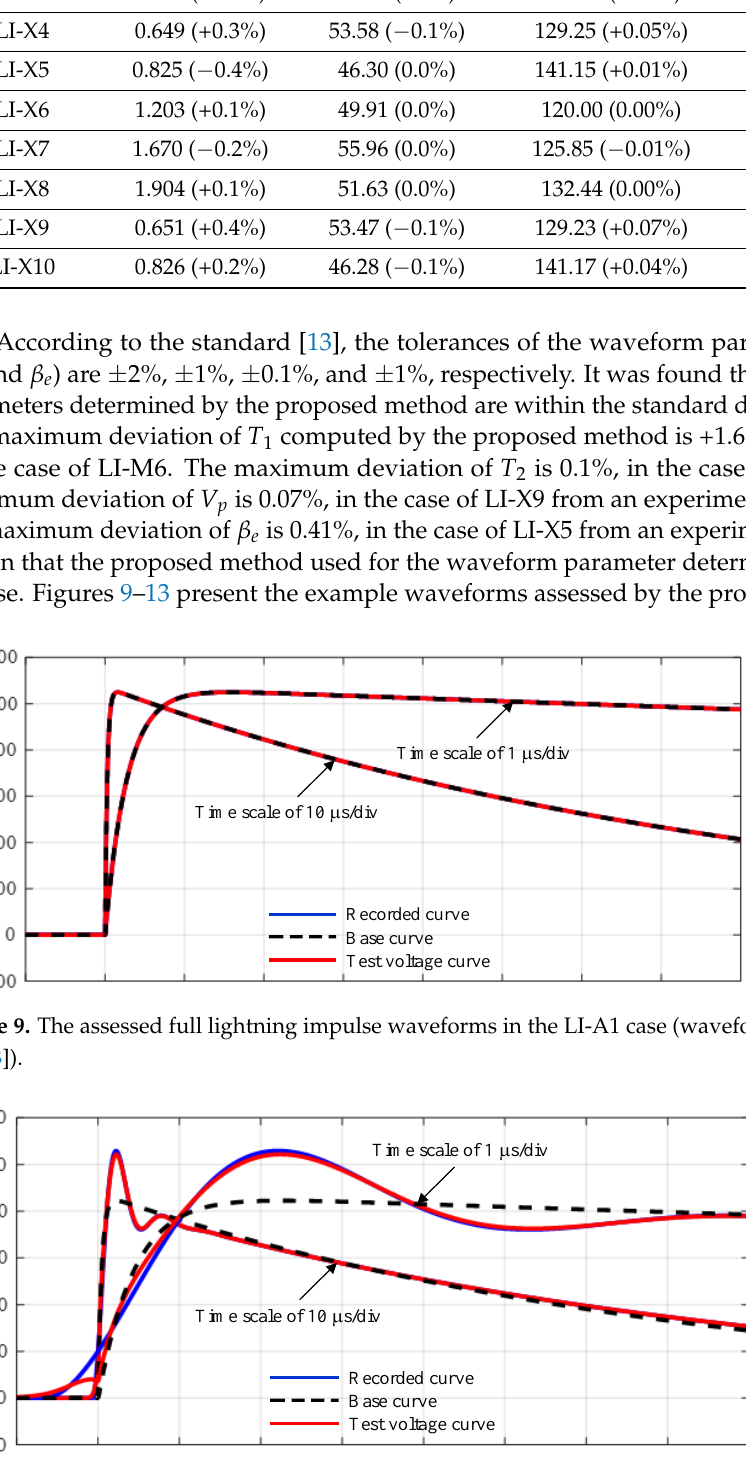
Figure 10. The assessed full lightning impulse waveforms in the LI-A7 case (waveform data pro- vided by [13]).